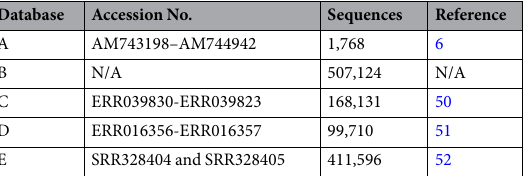
Table 3. Summary of in-house databases used to construct the T. circumcincta transcriptomic